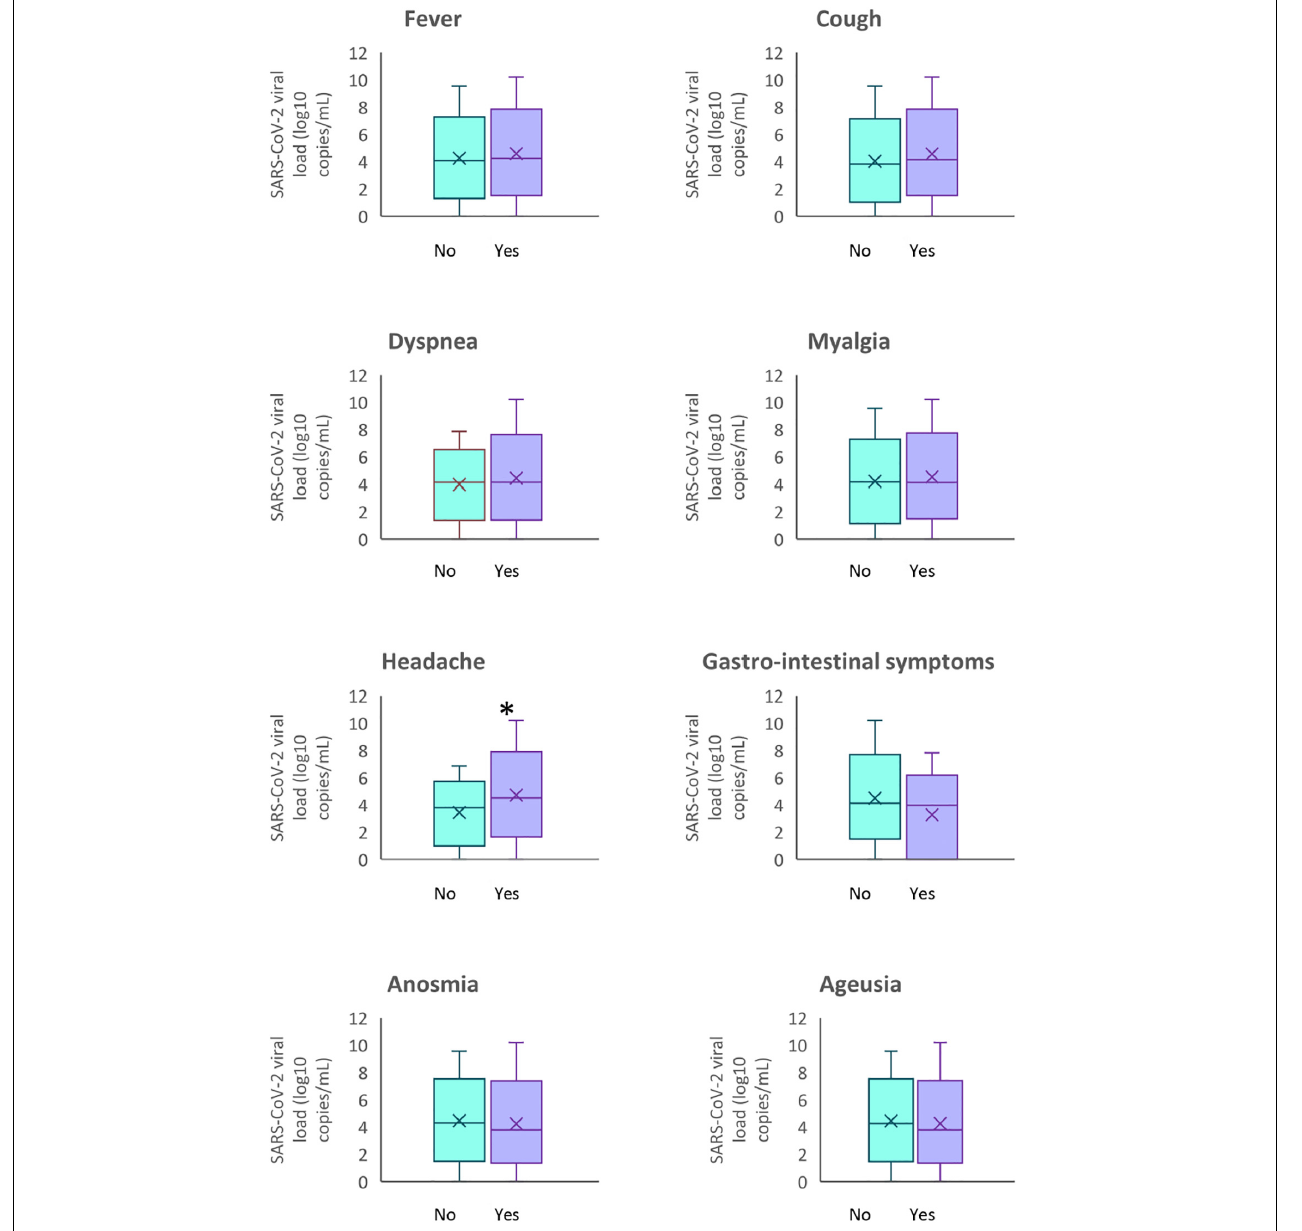
FIGURE 2 | SARS-CoV-2 viral load according to the symptoms of participants. * p < 0 .